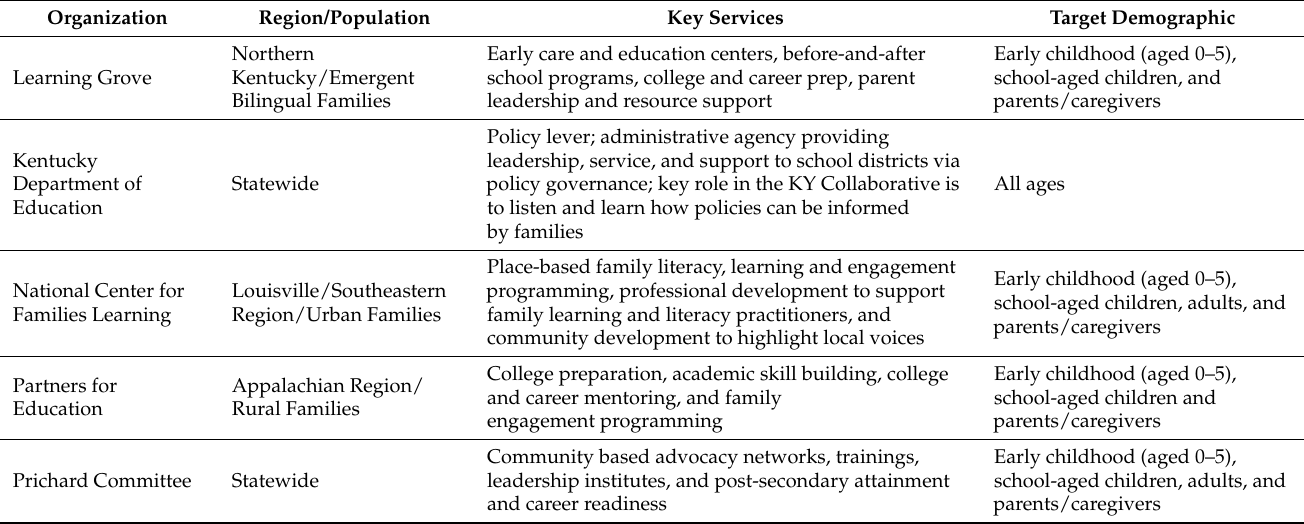
Table 3. Description of Regional